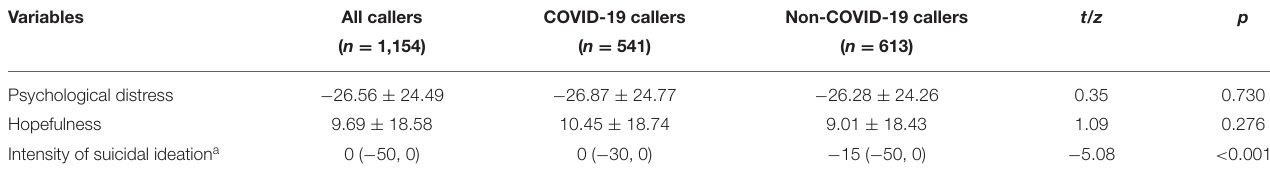
TABLE 4 | Comparison of changes in psychological variables before and after intervention between COVID-19 callers and non-COVID-19 callers [( ¯ x ±